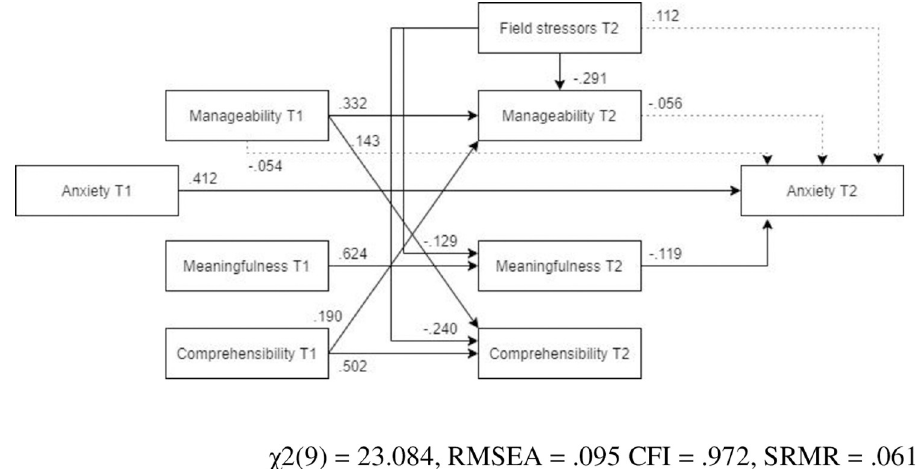
Fig 4. Tested structural equation model for anxiety—males. χ 2(9) = 23.084, RMSEA = .095 CFI = .972, SRMR = .061.